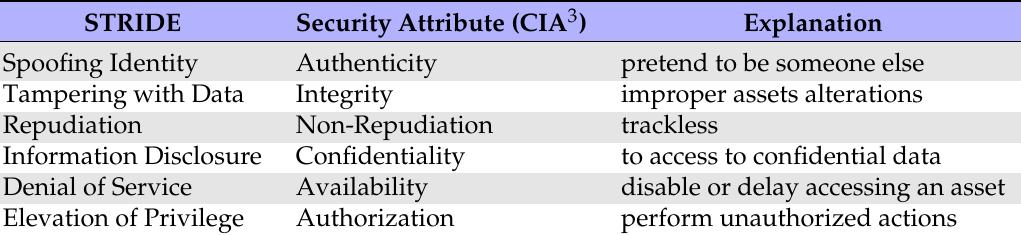
Table 1. Mapping STRIDE with CIA 3 security